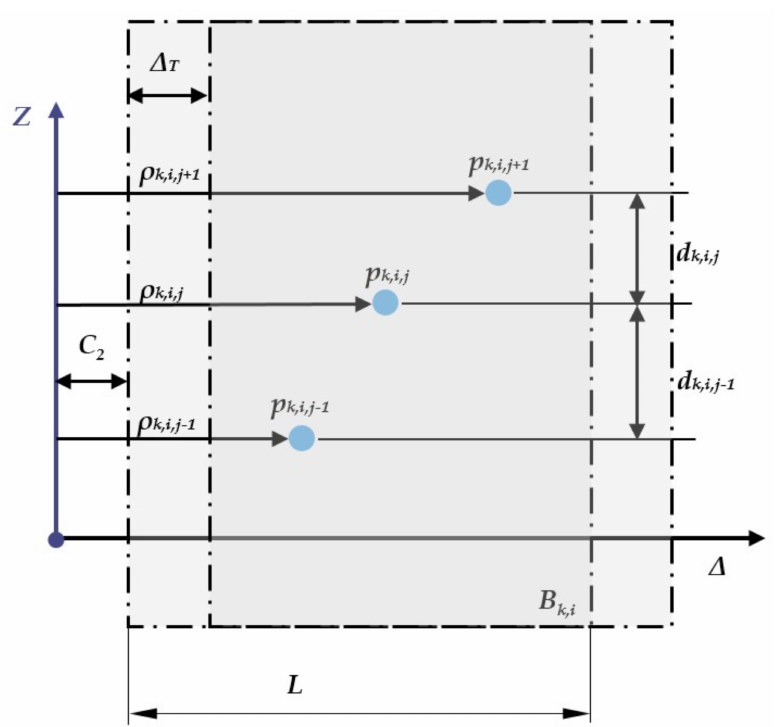
Figure 4. The graph’s side view concerning the points separation process and the p k,i,j points parameter selected by the B k,i